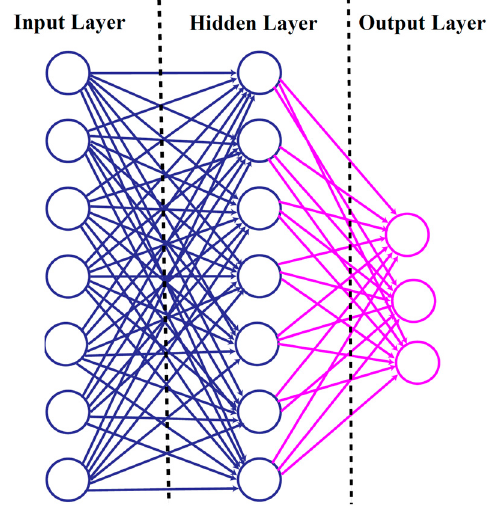
Figure 2. Neural network structure for implementing the diagnostic technique.